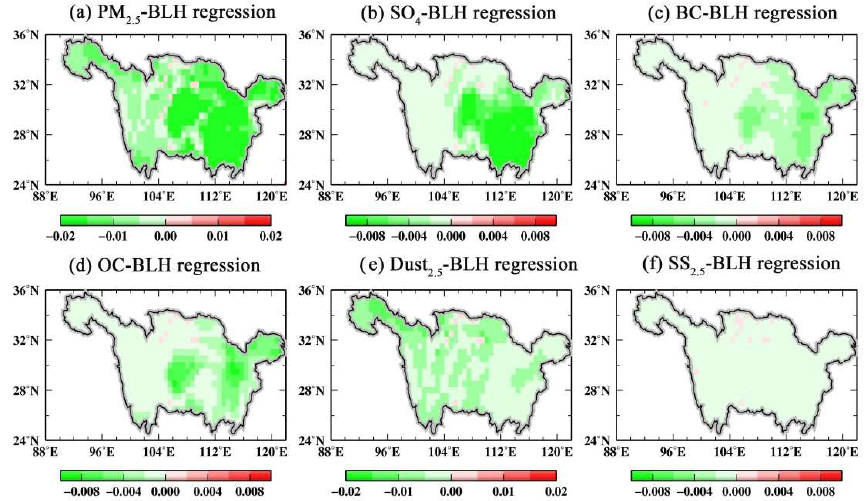
Figure 17. Multiple linear regression coefficients ( β 6 ) of each PM 2.5 component with boundary layer height (BLH), in units of µ g m − 3 m − 1 . ( a – f ) refer to the regression coefficients of PM 2.5 , SO 4 , BC, OC, Dust 2.5 and SS 2.5 with boundary layer height, respectively.